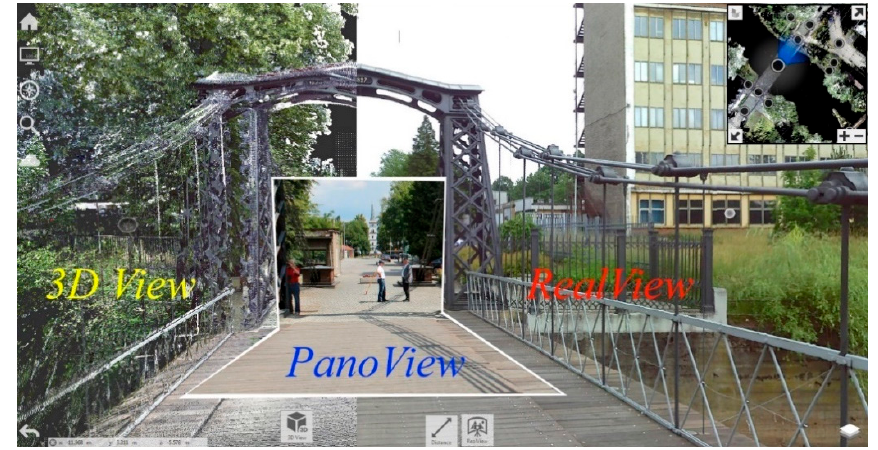
Figure 9. Comparison of (left) TLS 3D view, (right) real view in the Recap Pro environment and (middle) graphic supplementation from PANOTool (panorama implemented with PanoView).